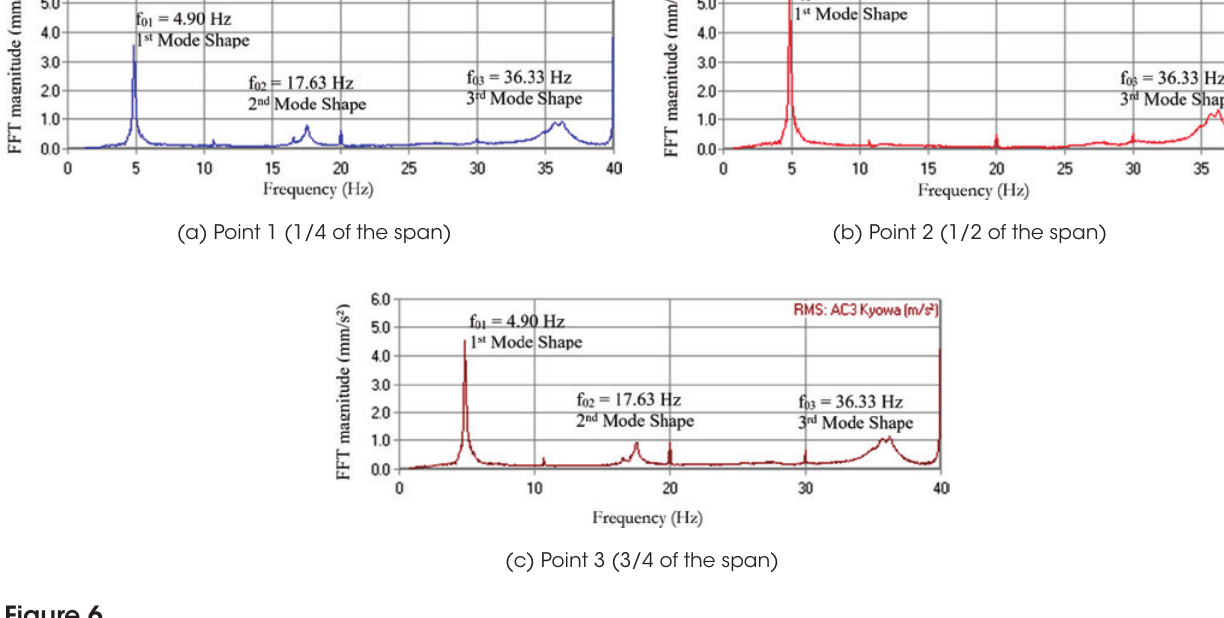
Experimental FFT magnitudes of the footbridge mode shapes